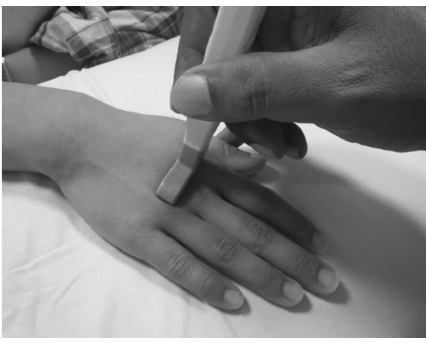
Figure 1: Position for examination of the hands. The neutral dorsal transversepositionofthetransducerinlinewiththeradialandulnar bare area of the metacarpophalangeal